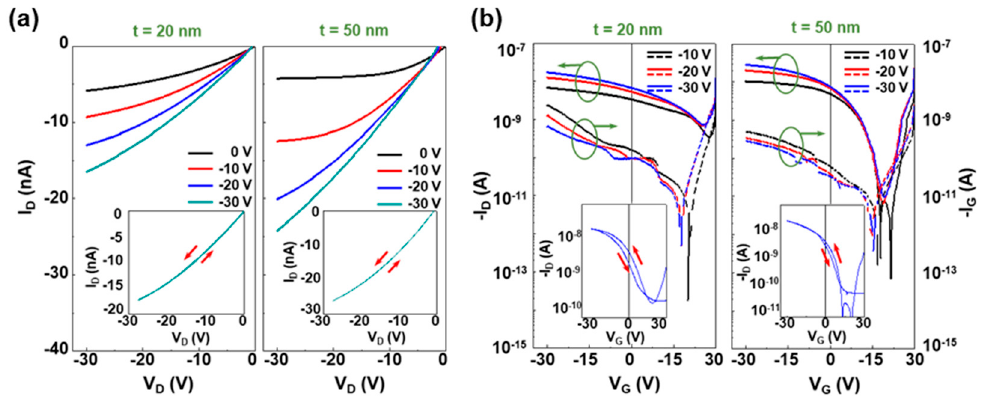
Figure 2. ( a ) Output and ( b ) transfer curves (left: drain current, right: gate current) of the NIR-OPTRs with the CDS structures in the dark according to the thickness (t) of PMMA DLs (left: t = 20 nm, right: t = 50 nm). The inset graphs in (a) show the representative output curves (swept between V D = 0 V and V D = − 30 V) at V G = − 30 V, while those in (b) show the representative transfer curves (swept between V G = 0 V and V G = − 30 V) at V D = − 30 V.